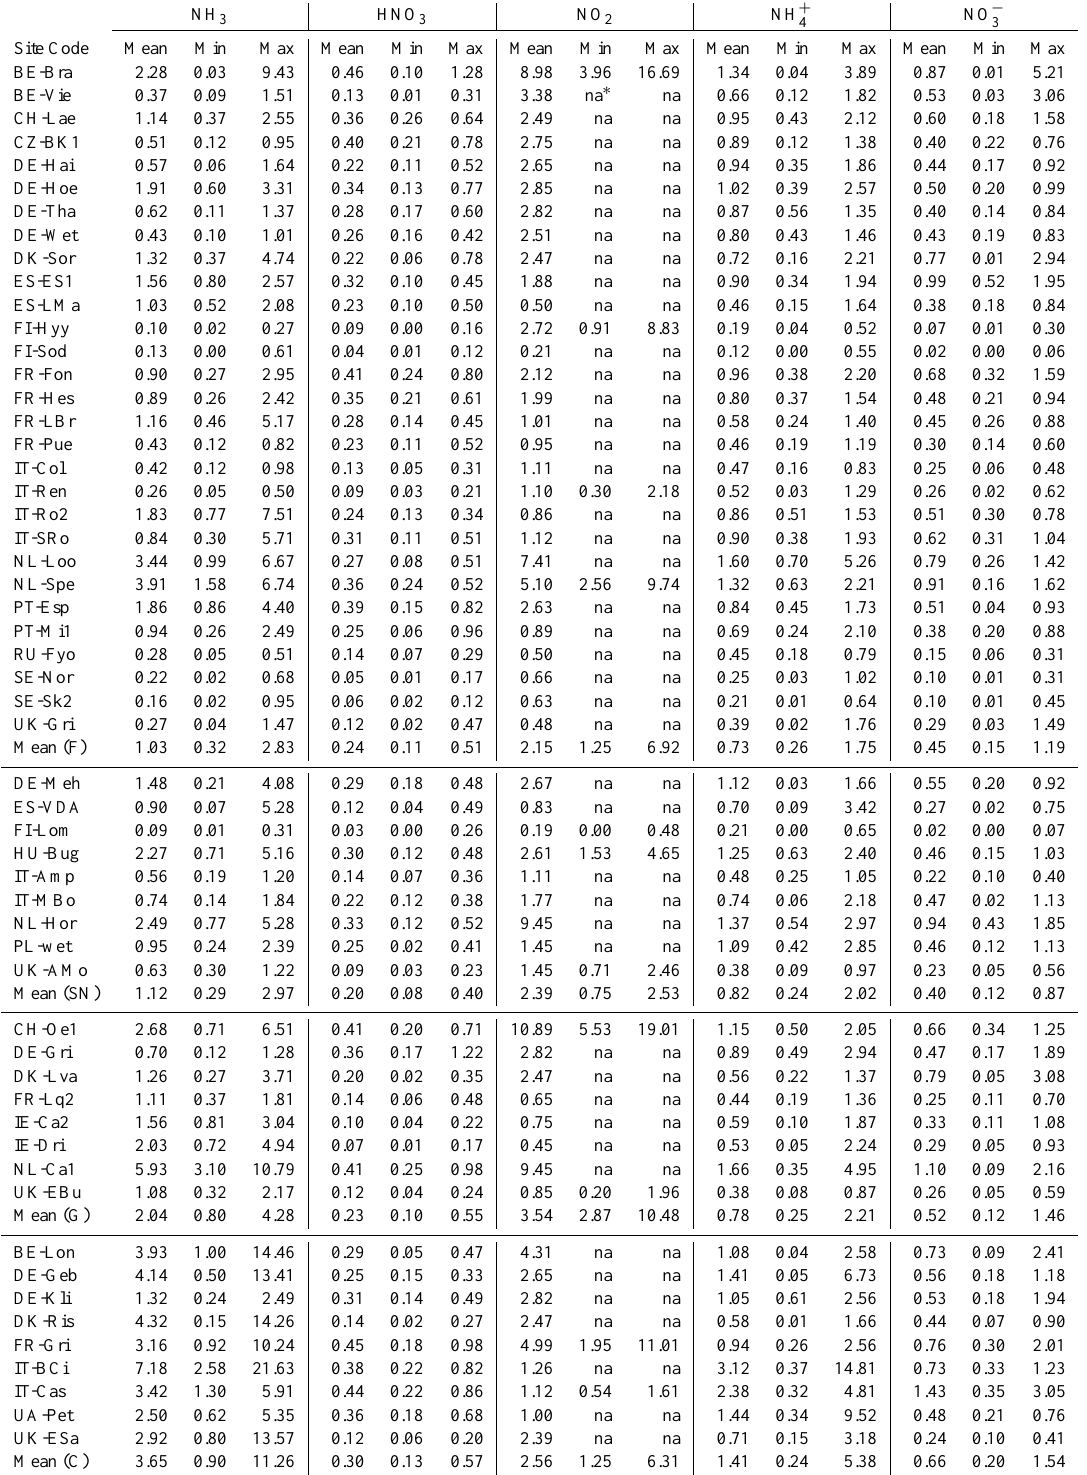
Table 2. Summary of ambient N r concentrations across the NEU inferential network (unit: µgNm − 3 ) . Data for NH 3 , HNO 3 , NH + NO − are arithmetic means, minima and maxima of 24 monthly values over the 2007–2008 period. Data for NO 2 are calculated from hourly 3 concentration measurements for some sites (see text), or from modelled EMEP 50 × 50km